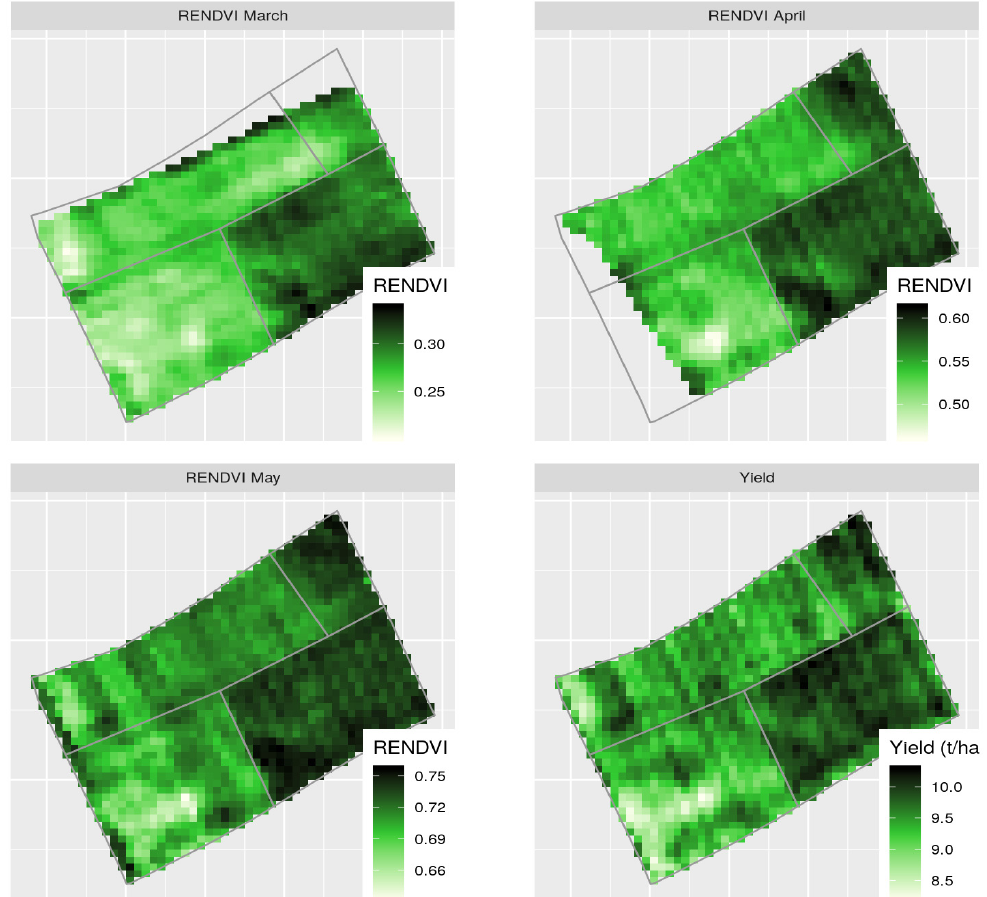
Figure 7. RENDVI acquired by MicaSense ® RedEdge-M TM sensor embedded on a quadcopter UAV and winter wheat grain yield (measured during the harvest on 17 July 2018 with a John Deere sensor) maps showing the crop growth heterogeneity and its continuity all along the considered growing period from March to July 2018. The gray lines illustrate the delineation of the previous four parcels A, B, C, and D (after suppression of headlands), which were merged into a unique field in spring 2017 (see Figure 1).